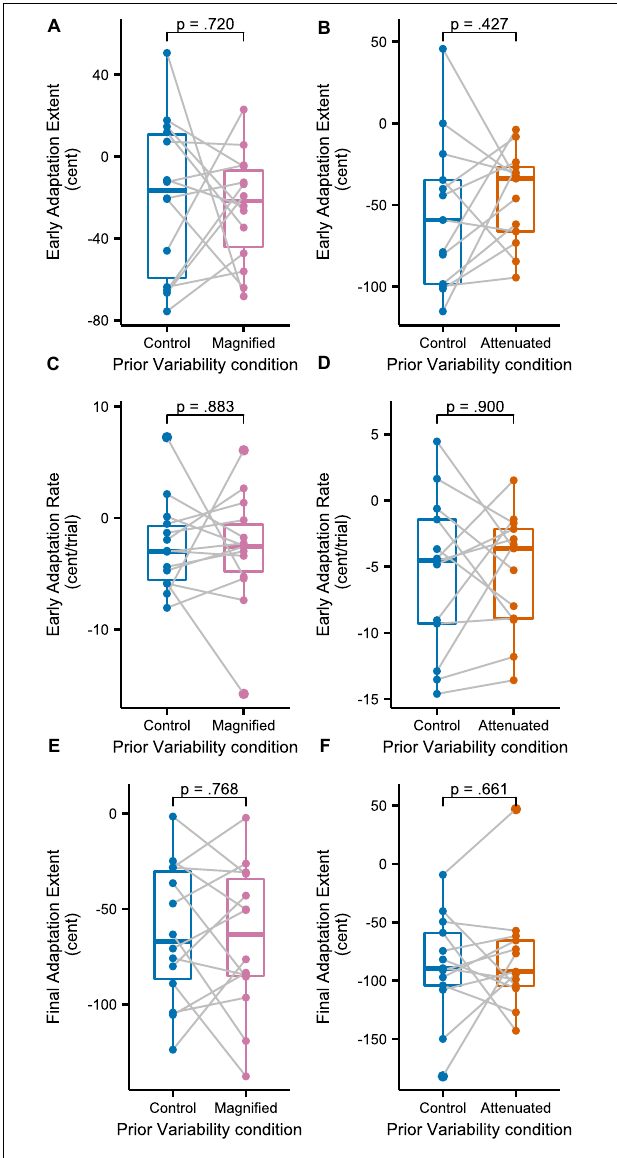
FIGURE 9 | Boxplots with symbols depicting each participant’s early adaptation extent (A,B) , early adaptation rate (C,D) , and final adaptation extent (E,F) for formant-shift adaptation completed after the Variability task’s Control and Magnified or Control and Attenuated conditions. Full statistics for these data: (A) t (13) = 0.366, p = 0.720, d = 0.098; (B) t (12) = –0.822, p = 0.427, d = 0.228; (C) t (13) = 0.150, p = 0.883, d = 0.040; (D) t (13) = –0.128, p = 0.900, d = 0.035; (E) t (13) = 0.301, p = 0.768, d = 0.081; (F) t (12) = –0.450, p = 0.661, d =